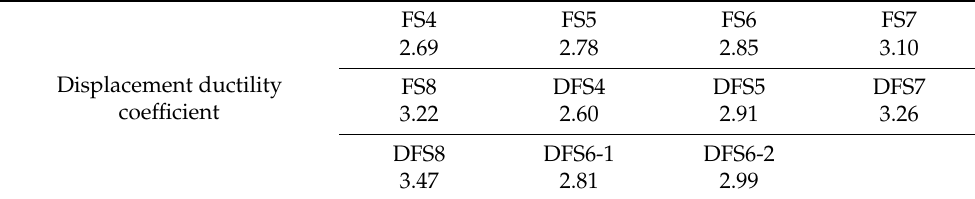
Table 5. Displacement ductility factors of PPSRC beam–column